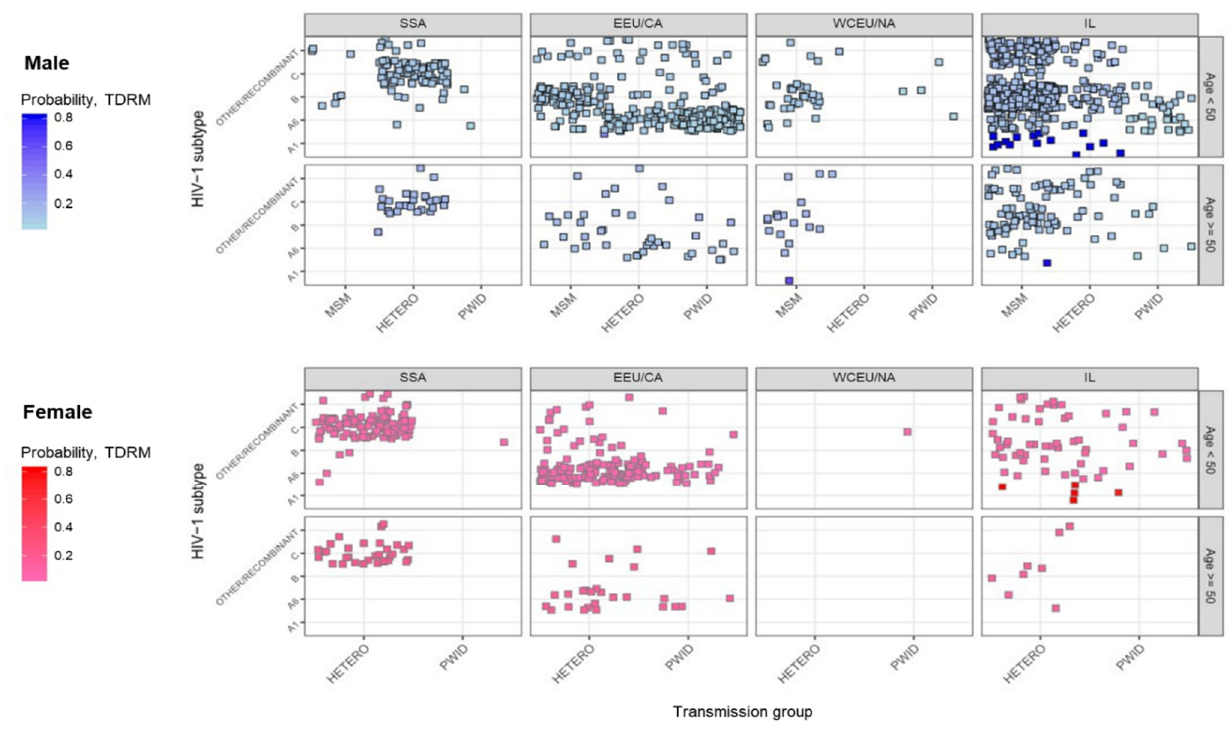
Figure 1. Probability of TDRM by sex, age, birthplace, HIV-1 subtype and transmission group. Following logistic regression analysis assessing predictors of TDRM (Table S5), all predicted